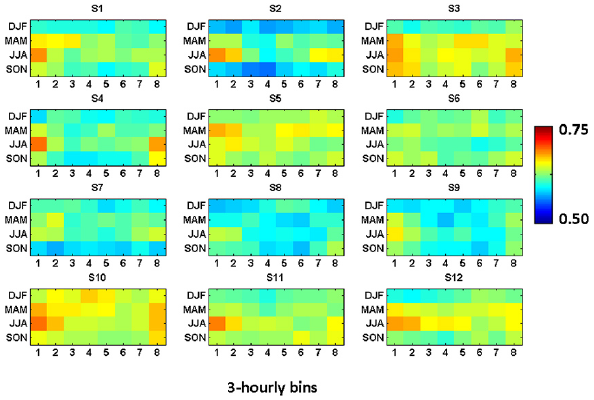
Figure 5. Coefficient of variation (standard deviation divided by mean) for precipitation for each 3h bin and season. The 12 subplots correspond to the 12 radar stations (denoted by S1 to S12) over Sweden. The geographical location of these sta- tions is shown in Fig. 1. The 3h bins numbered 1–8 are UTC hours from 00:00–03:00, 03:00–06:00, 06:00–09:00, 09:00–12:00, 12:00–15:00, 15:00–18:00, 18:00–21:00 and 21:00–24:00 respec- tively.